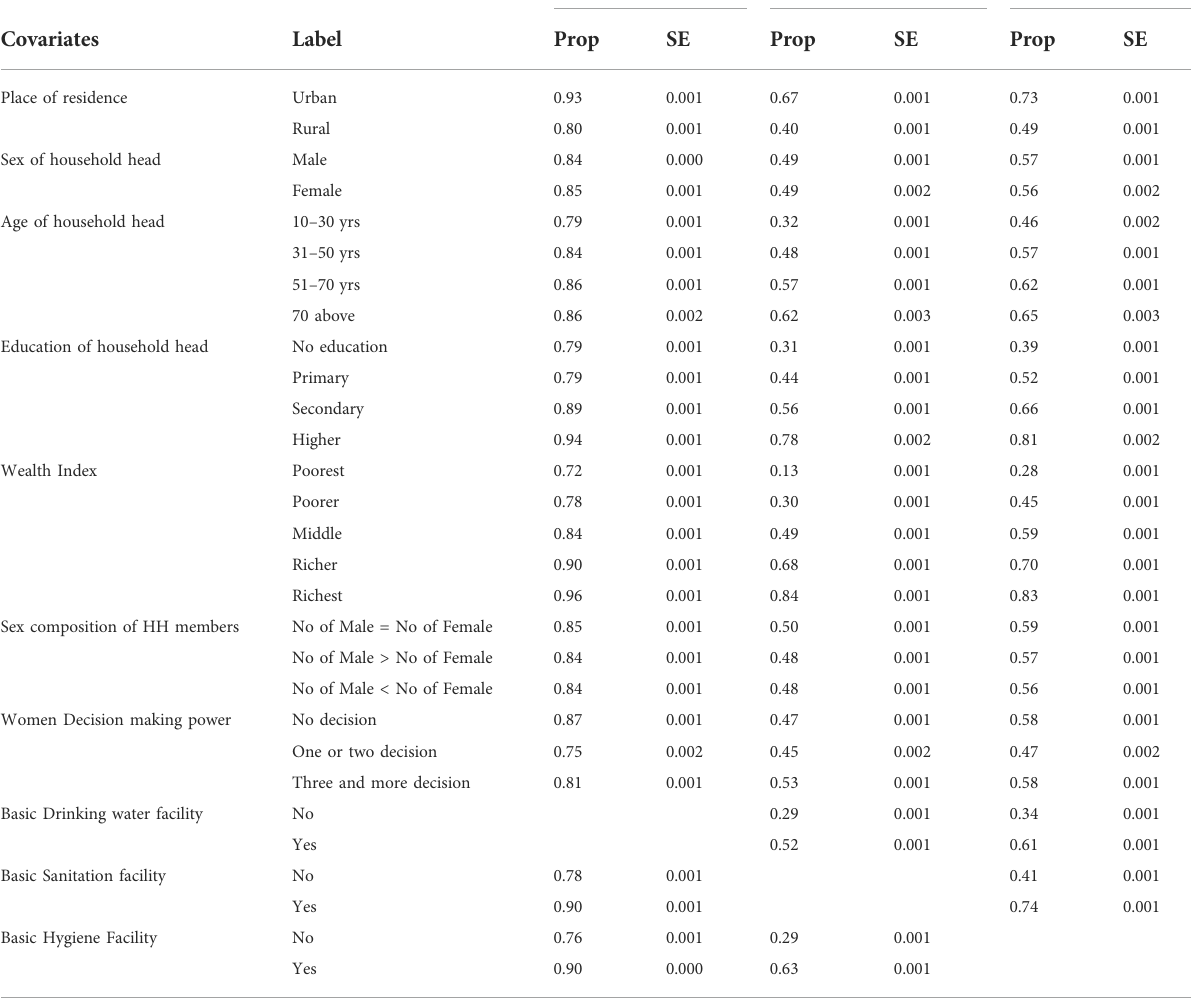
TABLE 1 Socioeconomic Indicators and Coverage of Basic WASH Services in 42 selected countries, 2010 –